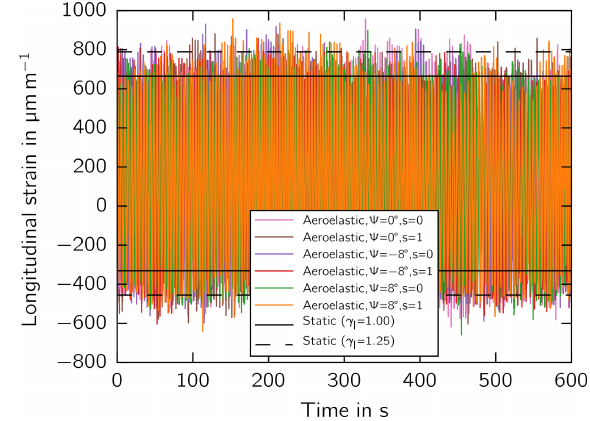
Figure 5. Strain history at z = 10 . 2m and v = 9ms − 1 ; (cid:57) denotes yaw error, and s denotes seed.